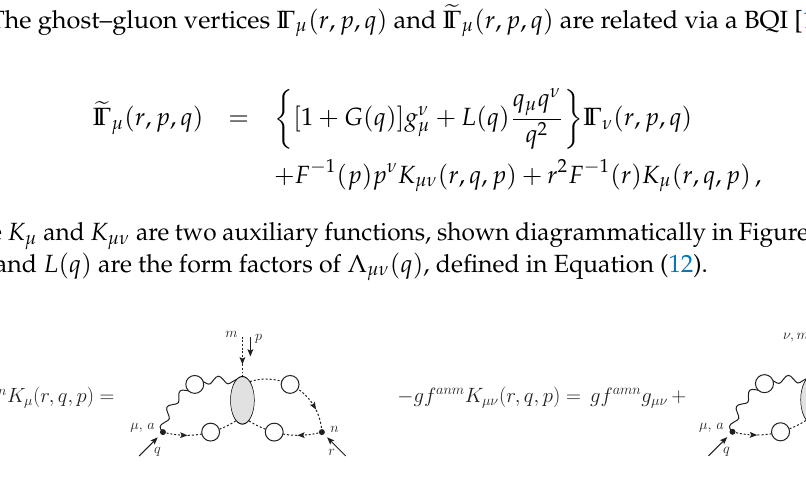
Figure A1. The auxiliary functions K µ ( q , r , p ) and K µν ( q , r , p ) in the BQI of Equation